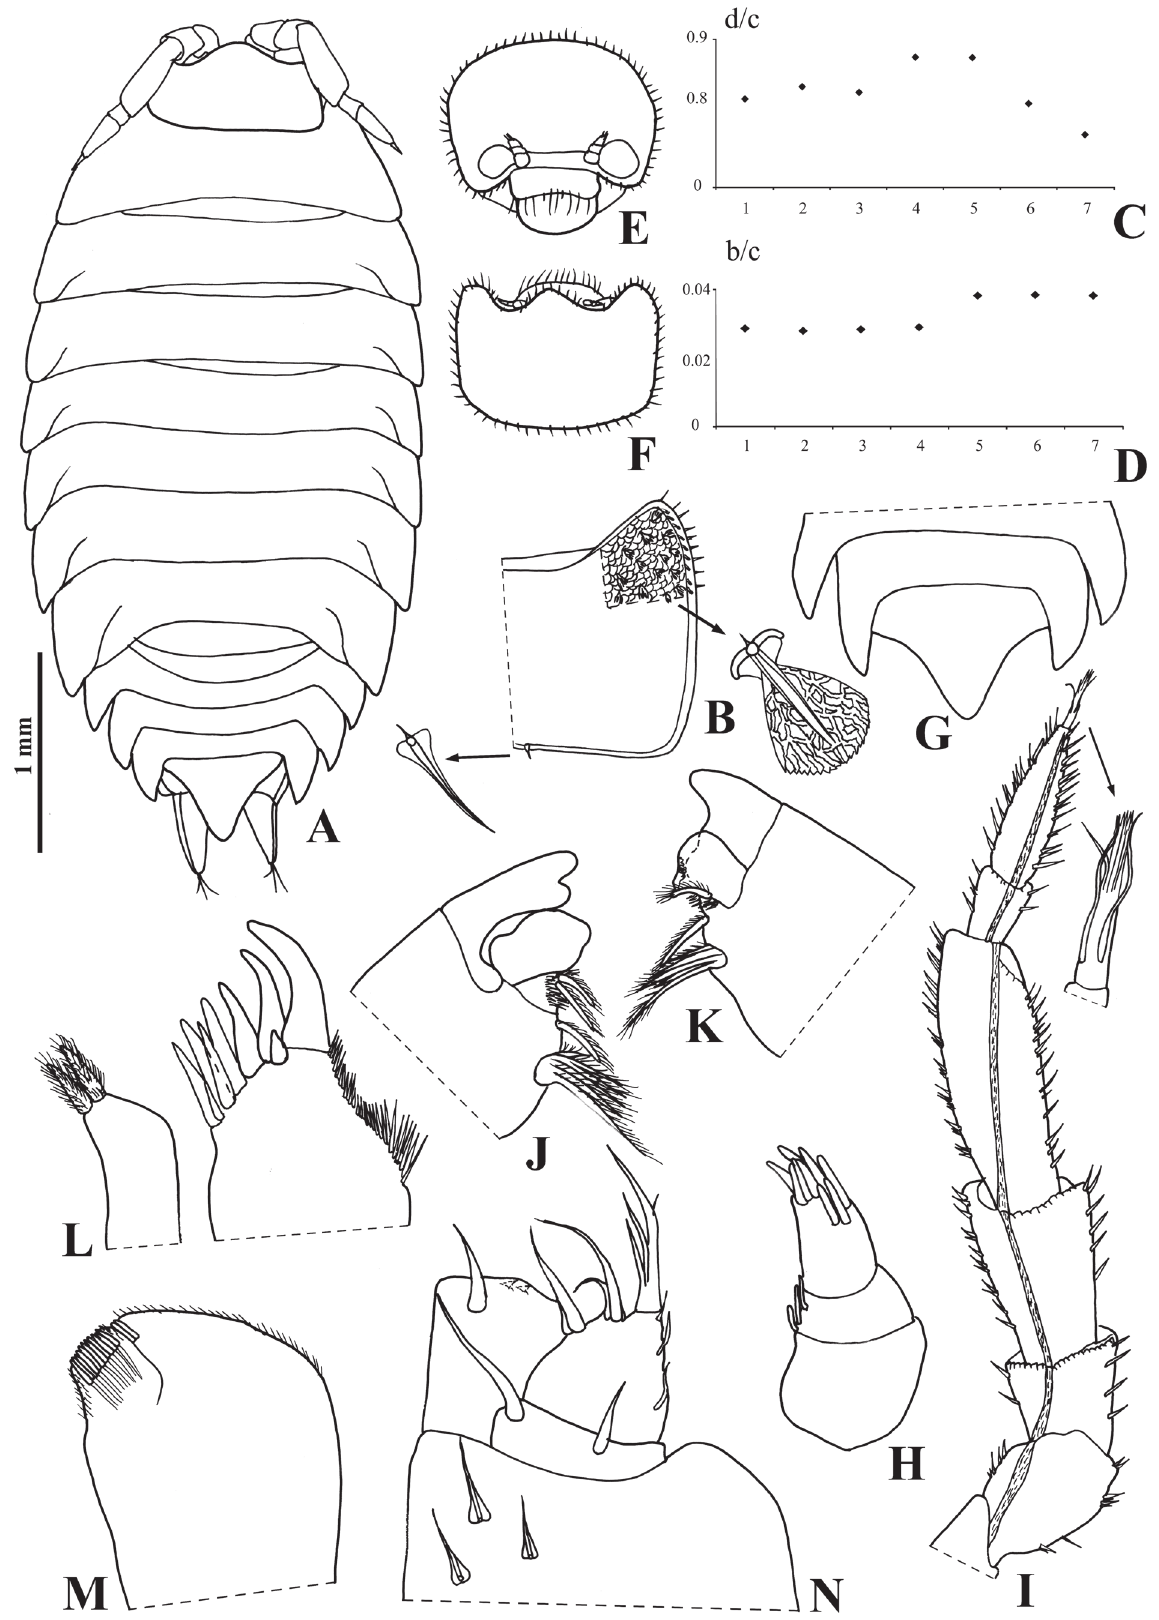
Figure 2 . Trichorhina kaingangi n. sp. (male paratype). A, habitus; B, pereonite 1, scale-seta and nodulus laterales ; C, noduli laterales d/c coordinates; D, noduli laterales b/c coordinates; E, cephalothorax, frontal view; F, cephalothorax, dorsal view; G, pleonites 4, 5 and pleotelson; H, antennula; I, antenna; J, left mandible; K, right mandible; L, maxillula; M, maxilla; N,